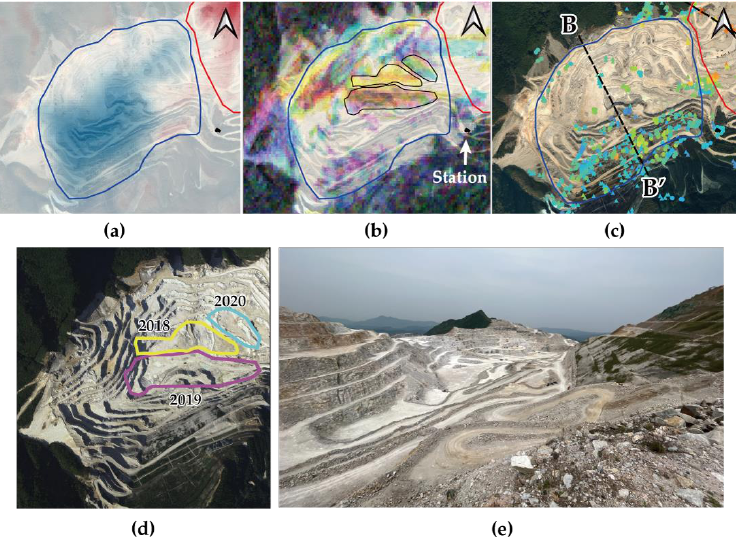
Figure 6. The resulting images of the mining area. ( a ) Elevation change, ( b ) RGB composited coherence image, ( c ) PSInSAR points from ascending (triangle) and descending (circle) orbit overlying a Google Earth satellite image from 2019, ( d ) an aerial photograph of 2021, and ( e ) a field photo taken in 2022.